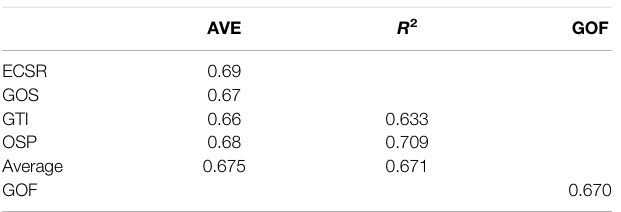
TABLE 7 | The goodness-of- fi t (GOF) index. AVE R